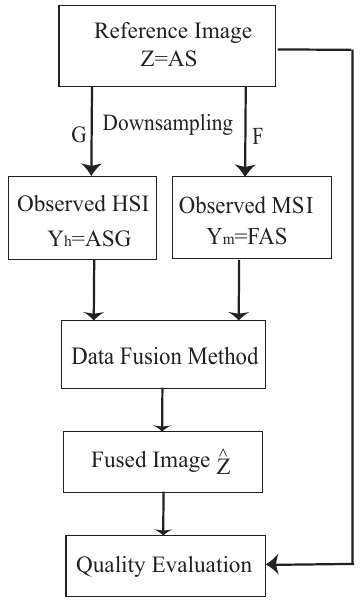
Figure 4. Flowchart of Wald’s